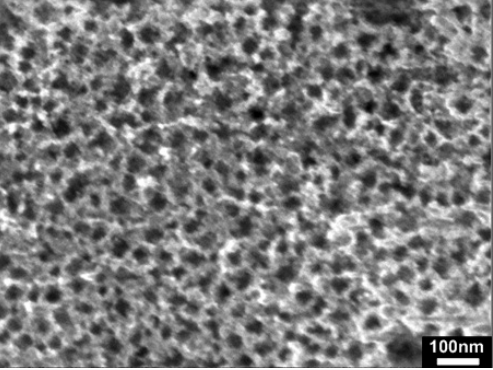
Figure 2. Field-emission scanning electron microscopy (FESEM) image of porous silicon (PS) substrate (top view).